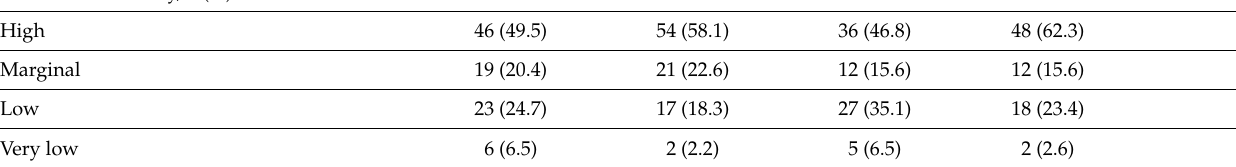
1 Analysis of covariance (continuous variables) or Cochran–Mantel–Haenszel chi-squared test (categorical vari- ables) evaluating differences in post-intervention values between intervention and control groups, controlling for pre-intervention values for respective outcome variable (unadjusted for other covariates). 2 Comparison between follow-up groups was significant; baseline values were not significantly